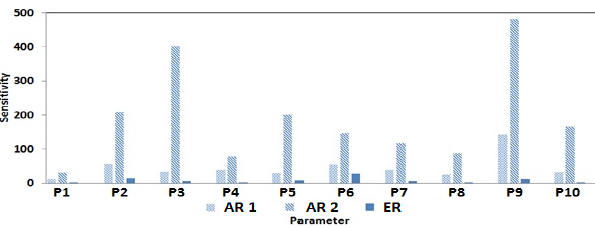
Fig. 9. Model sensitivity for recharge during 10 unsteady-state groundwater flow periods (P1 up to P10).